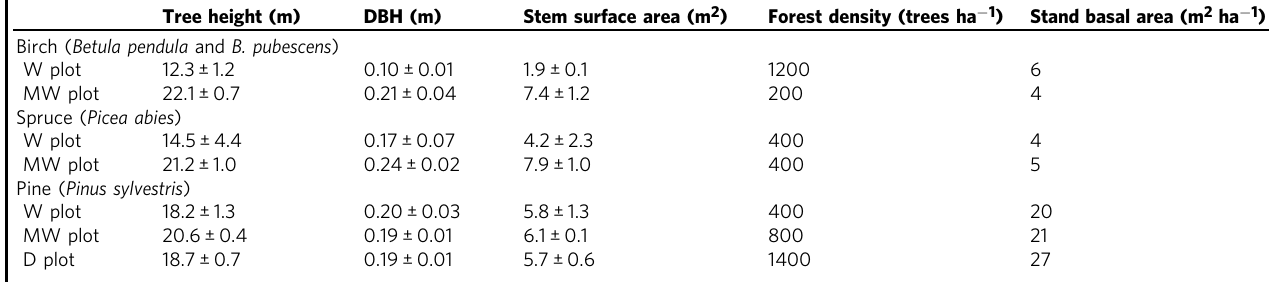
All variables (mean±standard deviation) are related to birch, spruce, and pine trees at wet (W), moderately wet (MW), and dry (D) plots. The dry plot did not have spruce or birch trees. Trees were approximately 50 years of age, except for three birches and one spruce on the wet plot, which were unambiguously younger. The forest density is de fi ned as number of individual trees per tree species and area unit of individual experimental plots. Stem diameter at breast height (DBH). Table modi fi ed after ref. 68